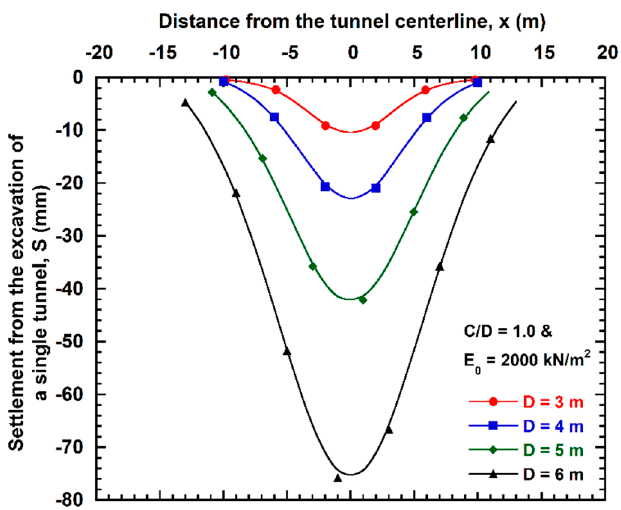
Figure 6. Effect of tunnel diameter on tunnelling induced ground settlement.